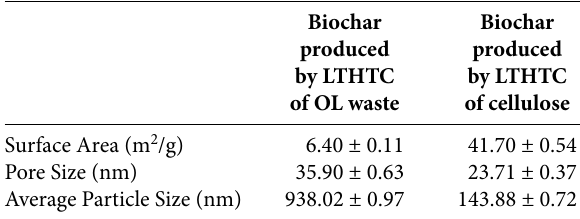
Table 1. Surface area, pore size and average particle size of biochar produced by LTHTC of OL waste and biochar produced by LTHTC of